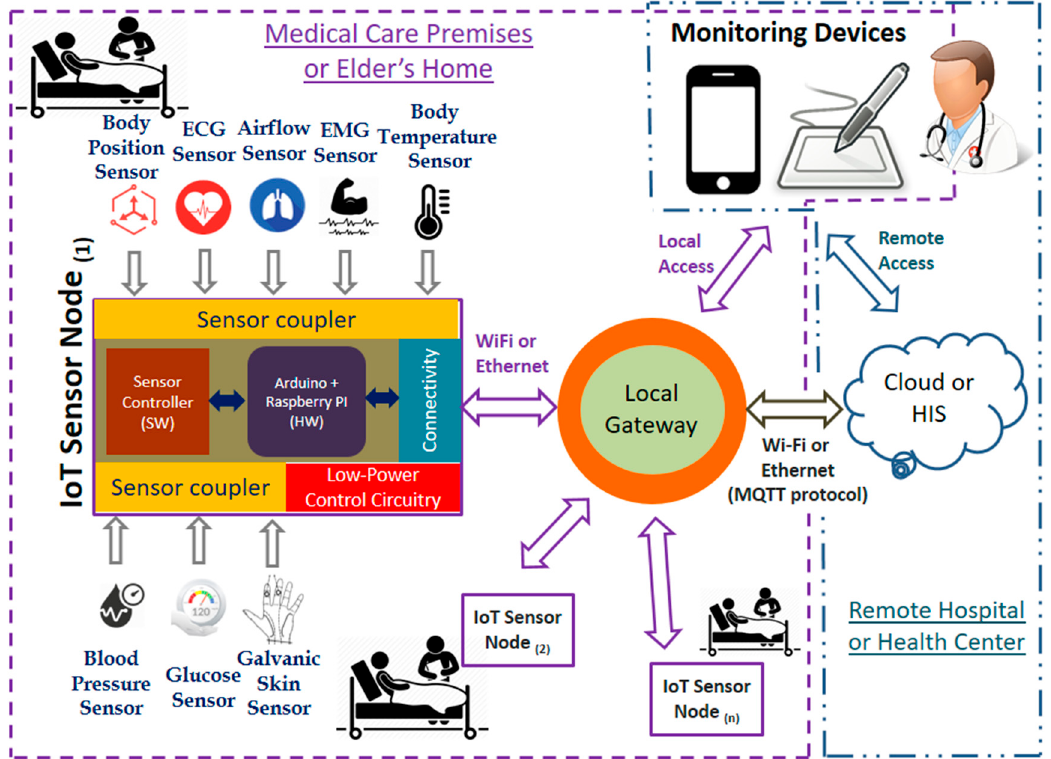
Figure 1. Architecture of the IoT e-Health environment. The IoT SN consists of the Body Sensors, the Sensor couplers, the circuitry system for low power control, the SC as SOFTWARE program that operates on the open source HW of Arduino and Raspberry PI and the connectivity infrastructure (Wi-Fi and Ethernet card). The sensor data are collected by an in-premises Gateway, which in turns sends them to the cloud platform based on the MQTT protocol. Each IoT SN is connected to the relevant individual under monitoring. Smartphones or Tablets can be used to monitor the vital signals of the individual either by connecting to the local gateway or to the cloud platform (or HIS).